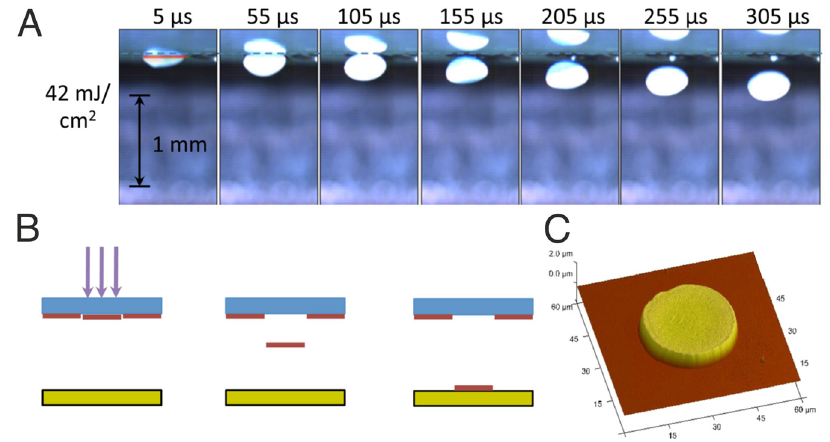
Figure 3. ( A ) Snapshots of a high-speed video of the transfer via LIFT of a high viscosity silver paste. In the top figure, a single laser pulse with a circular shape comes from the top, pushing downwards a ‘coin-like’ voxel that flies towards the receptor substrate without breaking. The schematics is included in ( B ), and a topography acquired via AFM of the final printed material is shown in ( C ). The figure has been reprinted from [10], with the permission of AIP Publishing (Copyright 2013).